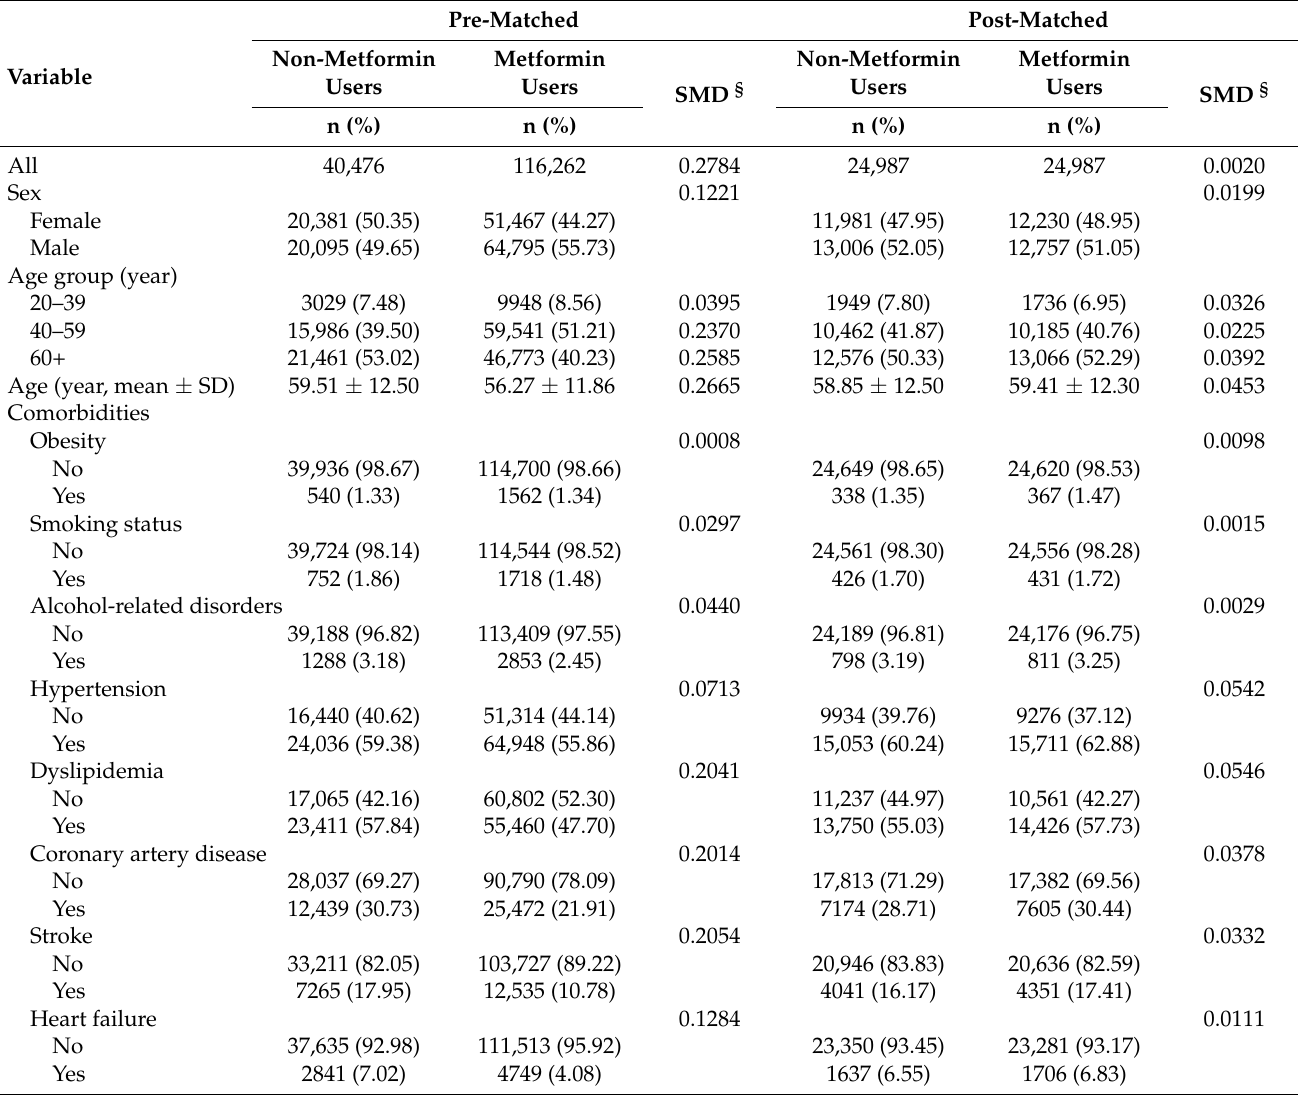
Table 1. Demographic characteristics, comorbidities, and medications in T2D patients with and without